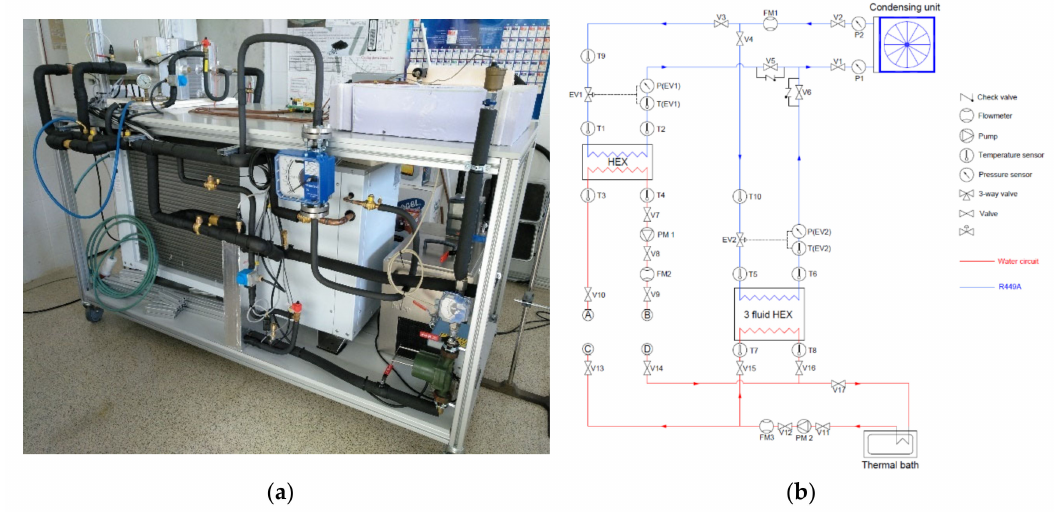
Figure 18. Picture ( a ) and scheme ( b ) of test facility “UDL-GREiA III”.